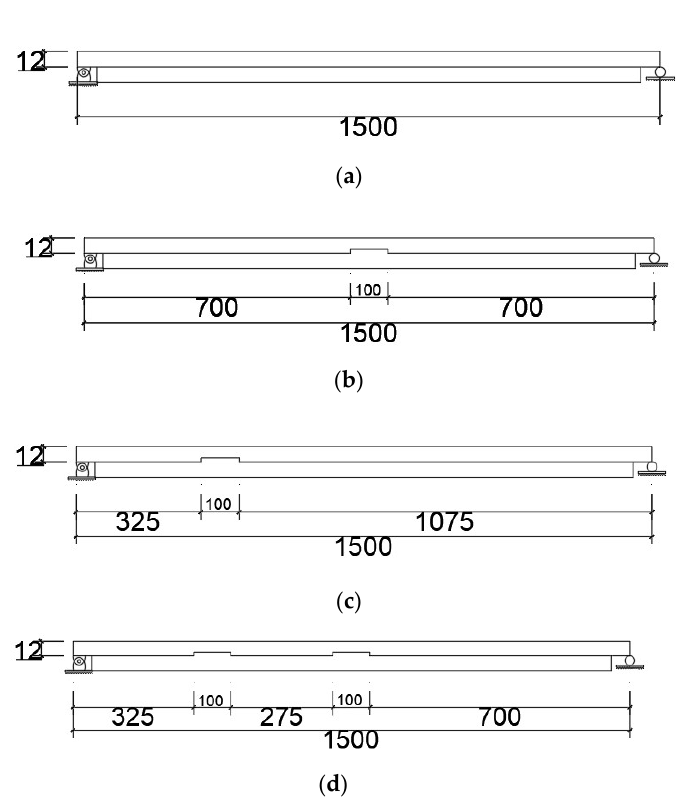
Figure 4. ( a ) Schematic diagram of stiffened and nondamaged condition; ( b ) schematic diagram of